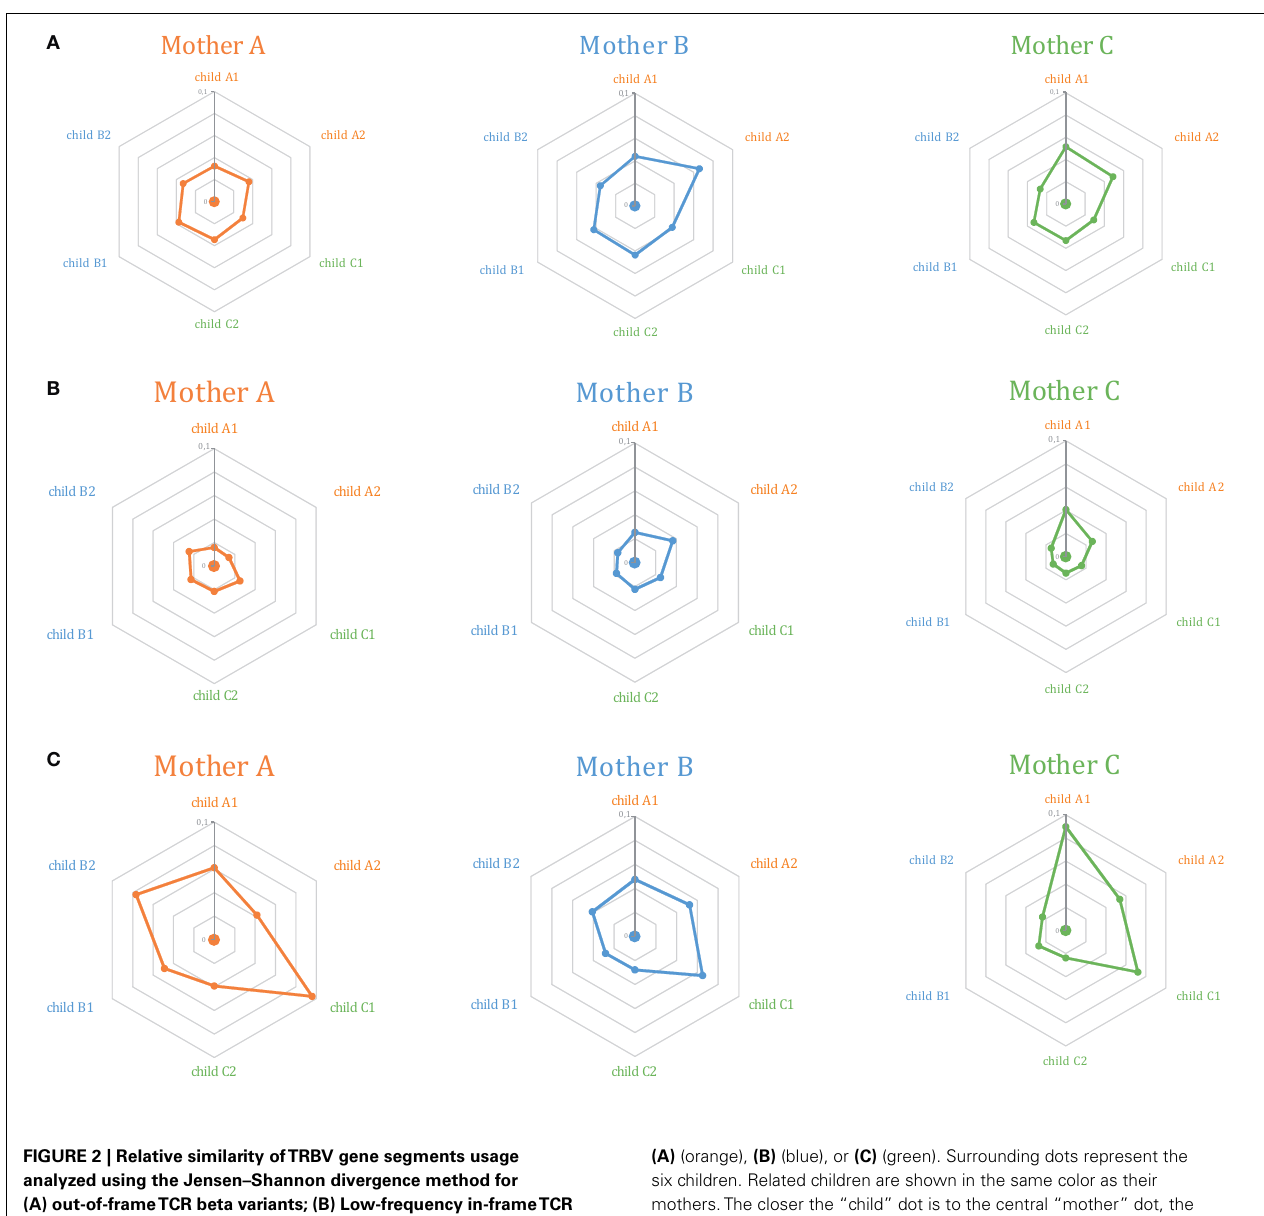
FIGURE 2 | Relative similarity ofTRBV gene segments usage analyzed using the Jensen–Shannon divergence method for (A) out-of-frameTCR beta variants; (B) Low-frequency in-frameTCR beta clonotypes; and (C) high-frequency in-frameTCR beta clonotypes .The central dot in each diagram represents Mother